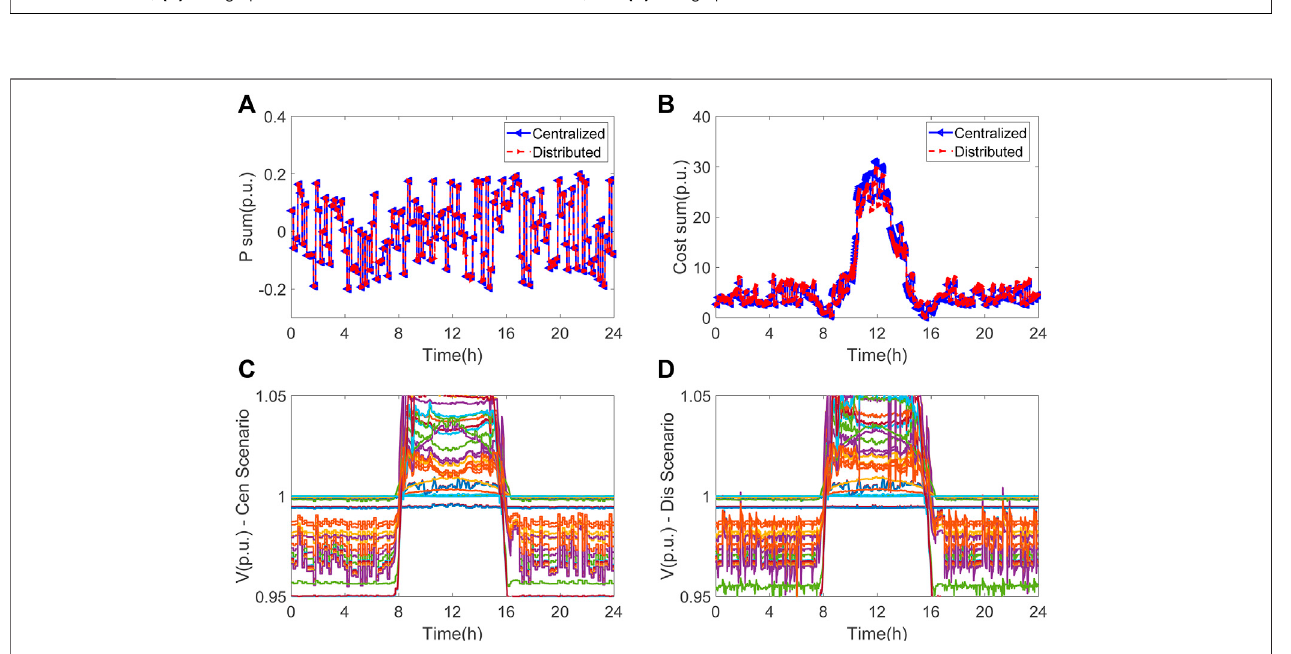
FIGURE5| CaseII:comparativeresultsofVSPdispatchusingacentralizedoptimizationandtheproposeddistributedcontrol: (A) VSPpoweroutputs; (B) storage costs in the VSP; (C) voltage pro fi le under the centralized control scenario; (D) voltage pro fi le under the distributed control scenario.